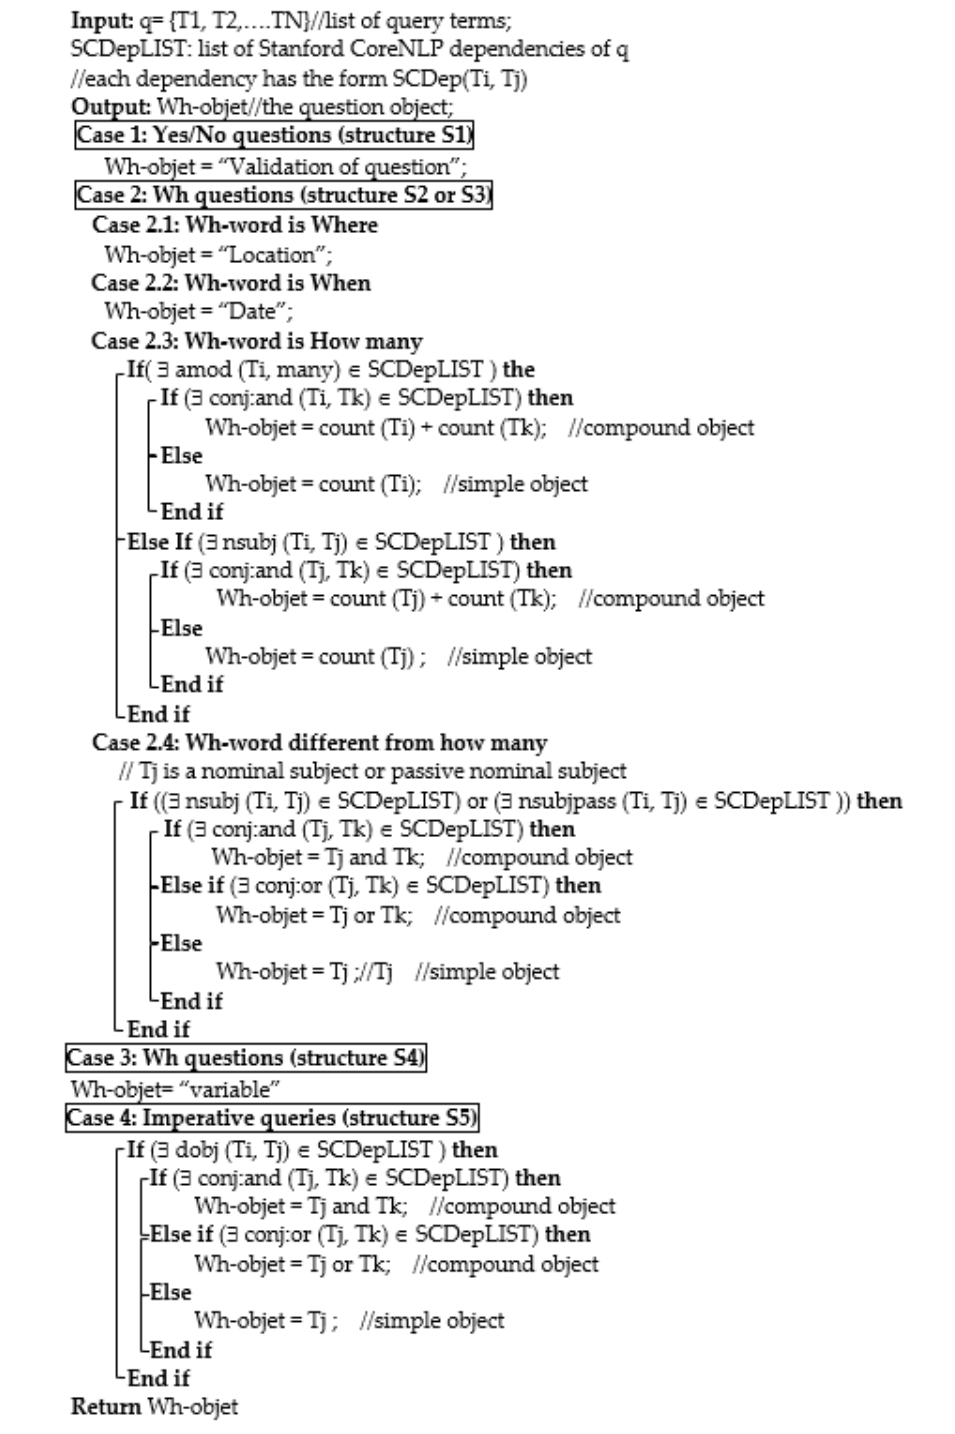
Algorithm 2: Identifying the question object